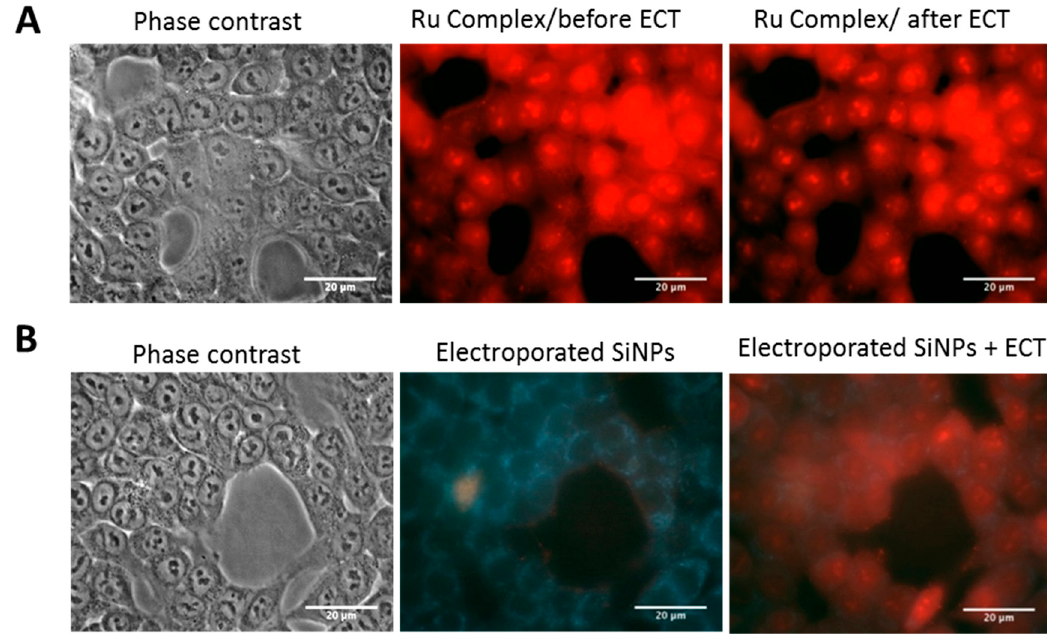
Figure 7. Visualization of cell labelling in HCT-116 cells. HCT-116 cells were incubated with ( A ) Ruthenium complex alone and ( B ) electroporated LumiLys 650 NPs and then visualized by wide field fluorescence microscopy (63× magnification). Phase contrast (first column) and fluorescence observations were performed 10 min after incubation with SiNPs before EP (second column) and just after ECT parameters (8 pulses lasting 100 μ s at 700 V/cm) (third column). Under UV excitation ( λ exc : 340–380 nm, λ em : 425 long-pass filter), cell autofluorescence appeared in blue while SiNPs’ fluorescence appeared in red. Scale bars correspond to 20 μ m.